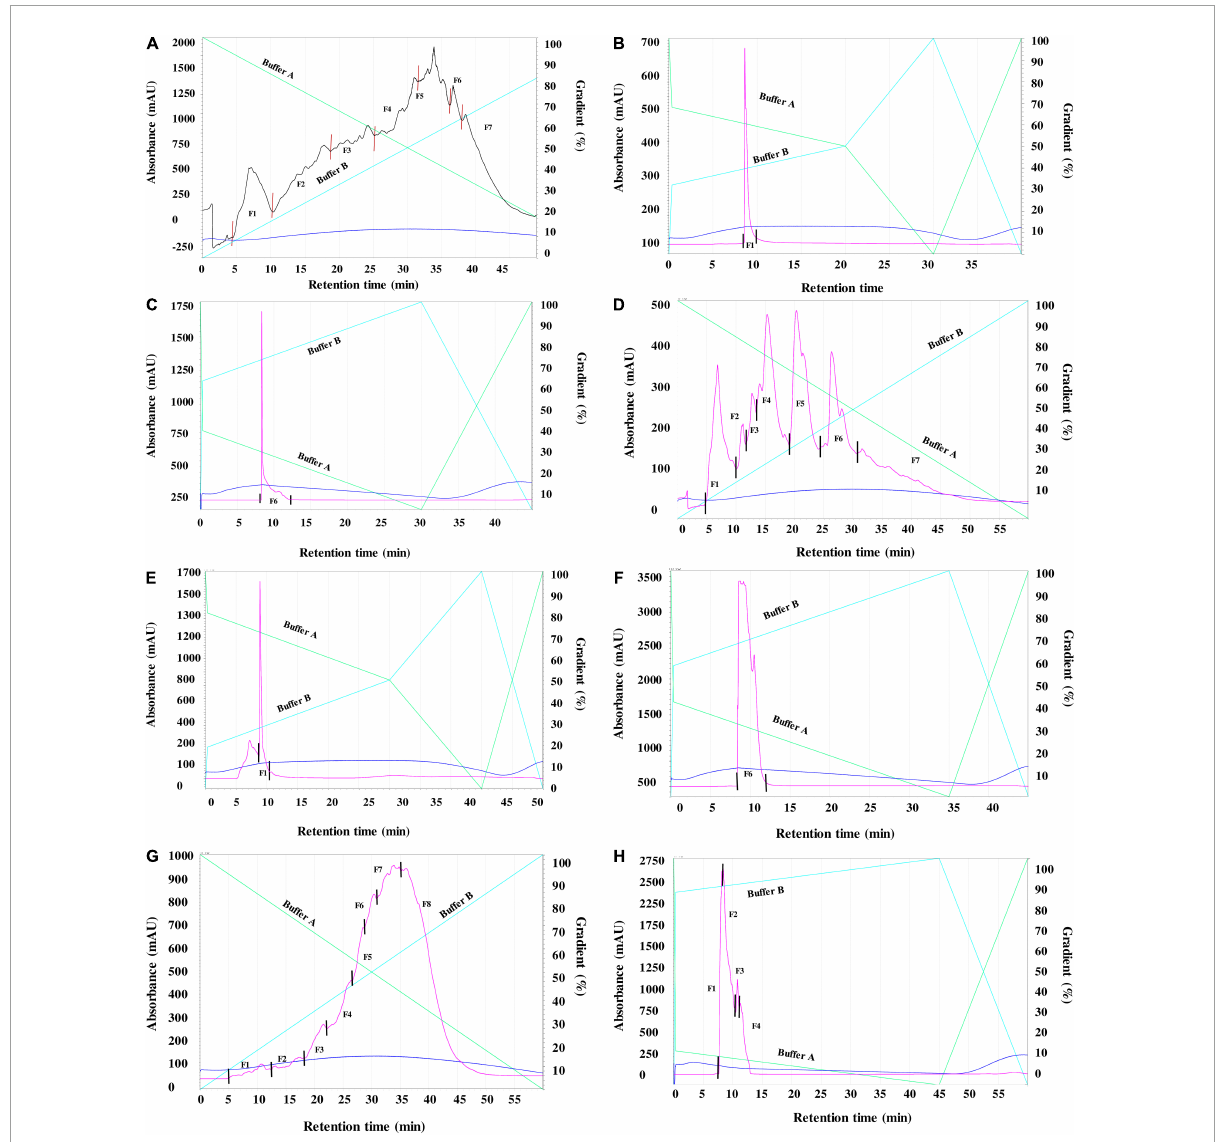
FIGURE1 (A) First round (R1) RP-HPLC separation of peptides derived from enzymatic digests of pea protein using 4% alcalase (Fractions 1–7). (B) : Second round (R2) RP-HPLC separation of peptides derived from enzymatic digests of pea protein using 4% alcalase (Fractions 1). (C) : Second round (R2) RP-HPLC separation of peptides derived from enzymatic digests of pea protein using 4% alcalase (Fractions 6). (D) : First round (R1) RP-HPLC separation of peptides derived from enzymatic digests of pea protein using 4% flavourzyme (Fractions 1-7). (E) : Second round (R2) RP-HPLC separation of peptides derived from enzymatic digests of pea protein using 4% flavourzyme (Fractions 1). (F) : Second round (R2) RP-HPLC separation of peptides derived from enzymatic digests of pea protein using 4% flavourzyme (Fractions 6). (G) : First round (R1) RP-HPLC separation of peptides derived from enzymatic digests of pea protein using 1% pepsin (Fractions 1-8). Figure (H) : Second round (R2) RP-HPLC separation of peptides derived from enzymatic digests of pea protein using 1% pepsin Fraction 8 (1-4).